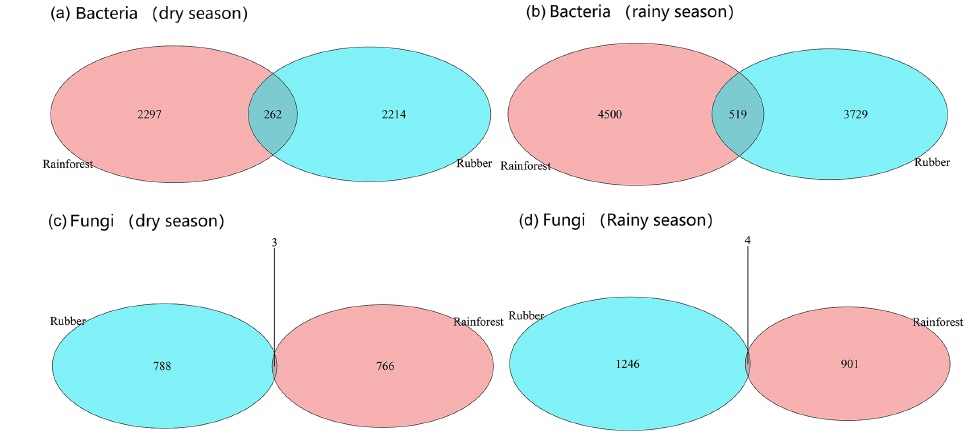
Figure 4. The number of shared and unique edges of soil bacterial and fungal networks in rubber plantations and tropical rainforests in the dry and rainy seasons. The number where the two circles cross is the number of shared edges. Numbers in the red circles present the unique edges in rainforests, whereas numbers in blue circles present the unique edges in rubber plantations.